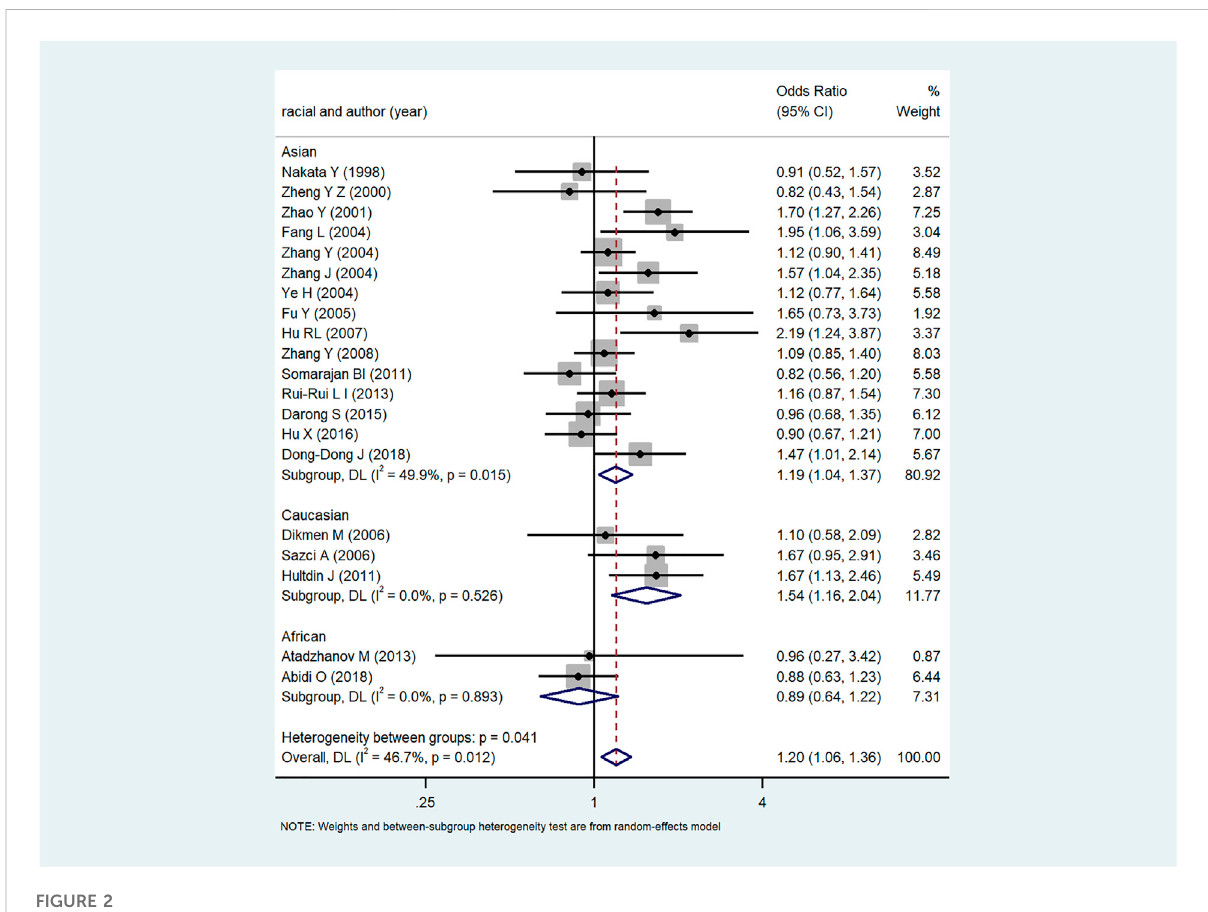
FIGURE 2 Homozygote gene model (TT VS. CC) in Asians, Caucasians, and